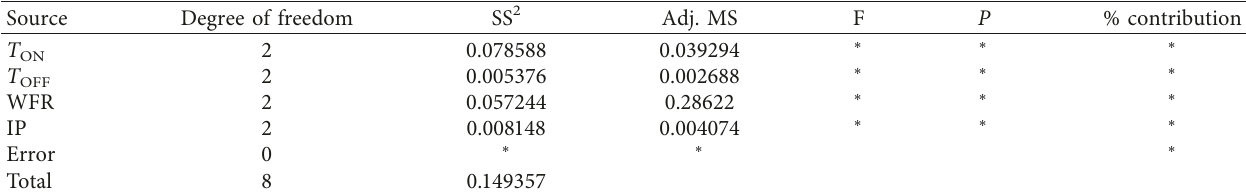
Table 10: ANOVA table for GFRG (before